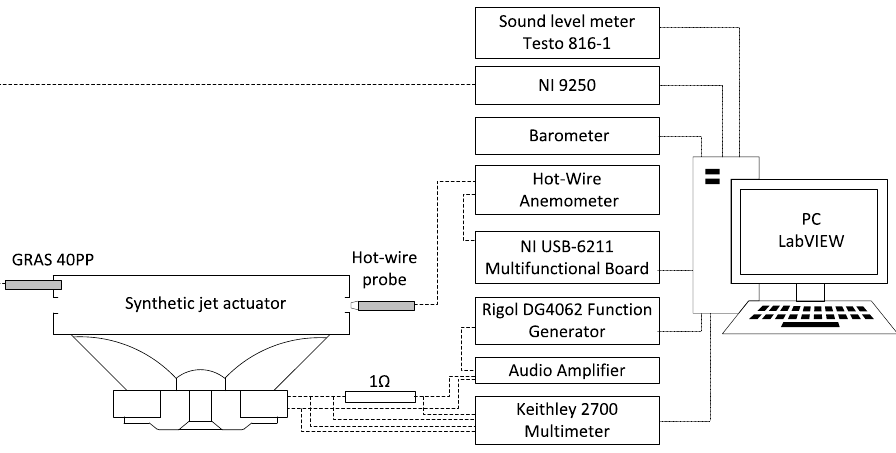
Figure 3. The scheme of the experimental set-up.